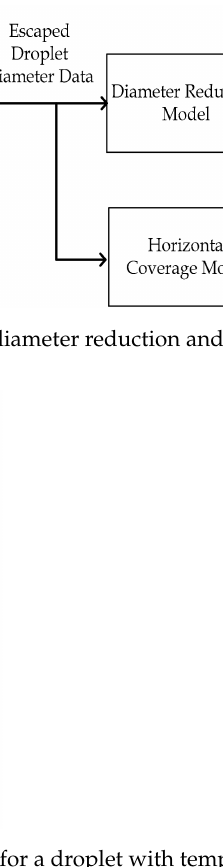
Figure 5. The evaporation and falling time for a droplet with temperature 33 ◦ C and RH 50%